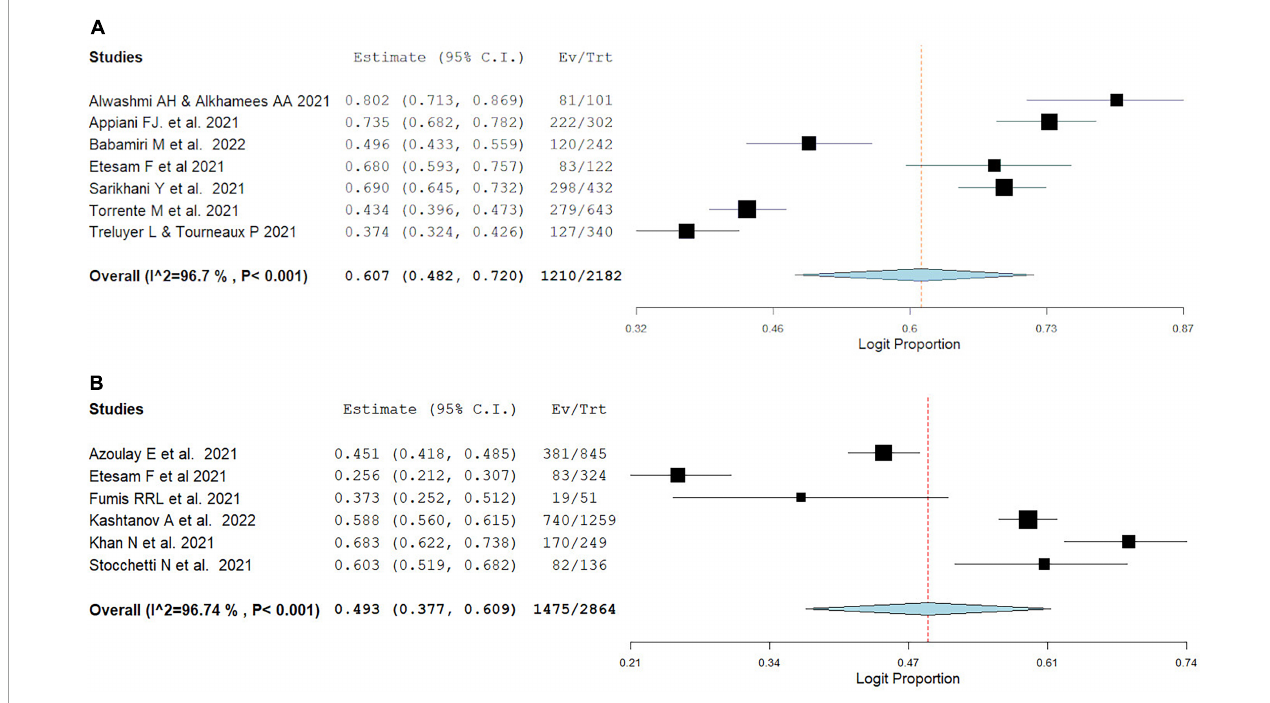
FIGURE3 Pooled estimate of burnout prevalence according to the Maslach burnout inventory in (A) early pandemic period, (B) late pandemic period.